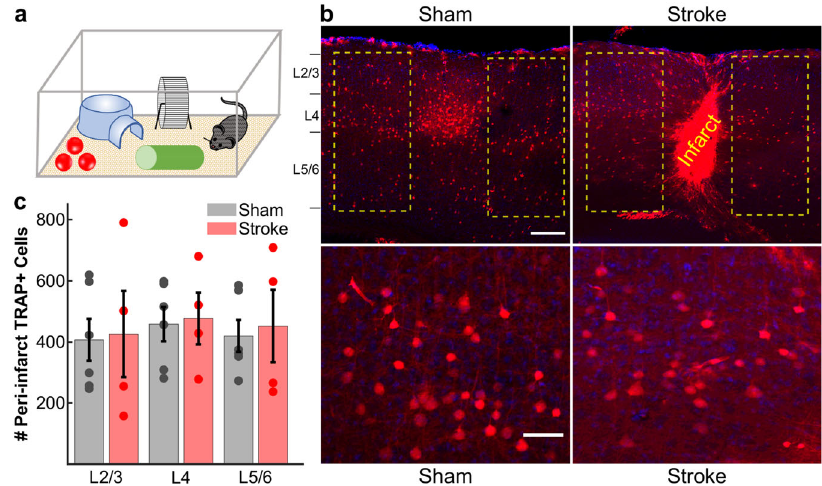
Fig. 3 TRAP labeling shows no increase in the numbers of C1 whisker-responsive neurons in the peri-infarct cortex 2 months after stroke. a Schematic of TRAP labeling approach. Two months after stroke targeting the C1 barrel, cFos-CreER T2 :Ai9 mice were subjected to whisker trimming (all whiskers except C1) and then allowed to explore an enriched environment, using only the right-sided C1 whisker for 6 h, immediately following injection of 4-OHT (50 mg/kg in corn oil). b Top: representative images (across n = 6 sham and n = 4 stroke mice) of activity-dependent TRAP labeling in S1BF. Putative C1 whisker-responsive neurons are labeled in red (tdTom); DAPI counterstain. Example regions for quanti fi cation are outlined in yellow surrounding either the intact C1 barrel in sham control mice (left panel) or the infarct core in stroke mice (right panel). Note the large density of cFos-expressing (TRAP + ) neurons in the C1 barrel in sham control mice. Scale bar = 200 μ m. Bottom: high magni fi cation of L4 TRAP-labeled cells surrounding the intact C1 barrel in sham control mice (left panel) or the infarct core in stroke mice (right panel). Scale bar = 50 μ m. c Quanti fi cation of the total number of TRAP + neurons in the peri-infarct cortex (stroke group, red, n = 4) or surround barrels (sham group, gray, n = 6), separated by cortical layers. No signi fi cant differences were found using a two-way ANOVA for effects of group ( p = 0.736), layer ( p = 0.828), or group × layer ( p = 0.995). Bars show mean ± s.e.m., with data points for individual mice